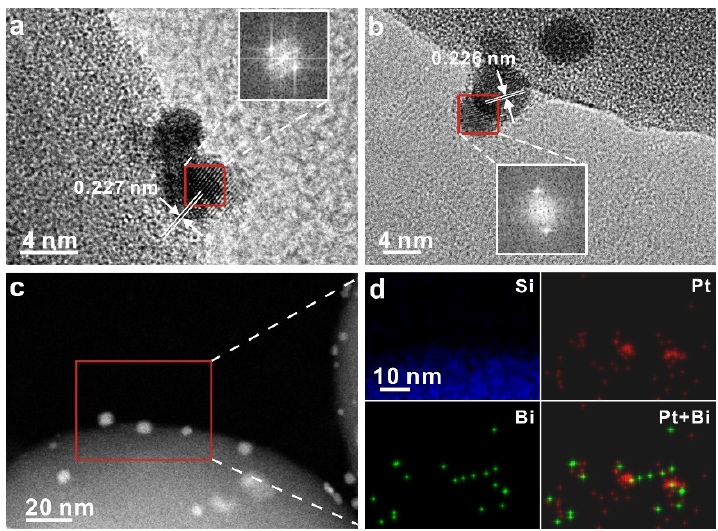
Figure 3. ( a , b ) HRTEM images of PtBi 0.2 /SiO 2 catalyst (the insets show corresponding FFT patterns). ( c ) HAADF-STEM image and ( d ) EDS mapping of PtBi 0.2 /SiO 2